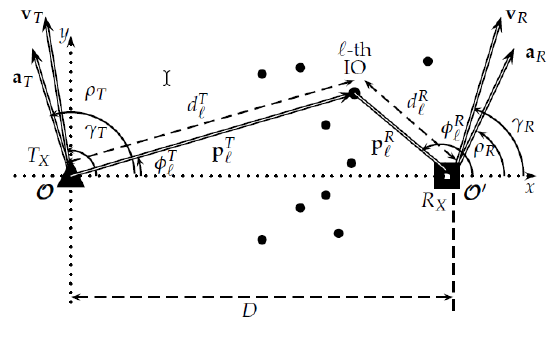
Figure 3. Reference propagation environment at t 0 = 0. Table 2. List of parameters that describe the propagation scenario ( x = M x ∠ Θ x denotes a vector x with magnitude M x and direction Θ x